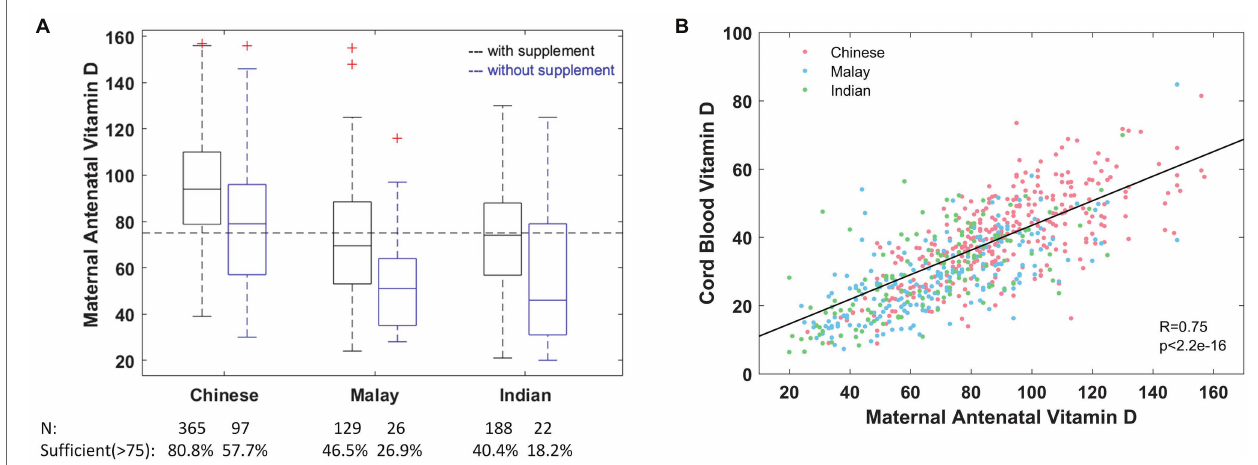
FIGURE 1 | (A) Maternal antenatal vitamin D concentration stratified by ethnicity and consumption of vitamin D containing supplements. (B) Cord blood vitamin D concentration is strongly correlated with maternal antenatal vitamin D across all ethnicities. The dashed horizontal line marks the level of sufficiency (>75 nmol/L) as recommended by the Endocrine Society Clinical Practice Guidelines (ESCPG; Holick et al., 2011). For visualization purposes, the y axis in (A) is truncated at 160 nmol/L, which excludes two high values (187, 195) from Chinese mothers who consumed vitamin D containing supplements.